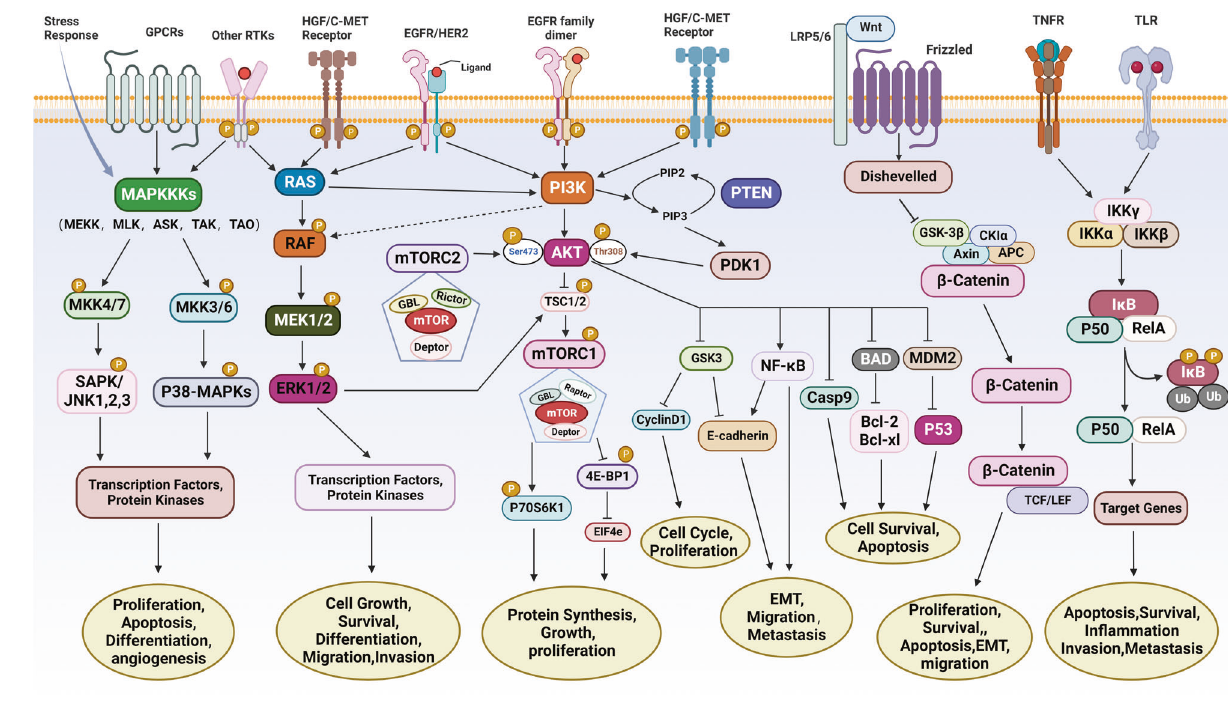
Fig. 2 Main signaling pathways and fundamental factors in gastric cancer. The major signaling and crosstalk of MAPK, HER2, PI3K/AKT/mTOR, HGF/c-Met, p53, Wnt/ β -catenin, and NF- κ B pathways, as well as their regulatory roles in cellular processes, are illustrated. GPCRs G-protein- coupled receptors, HGF hepatocyte growth factor, c-MET c-mesenchymal-epithelial transition factor, EGFR epidermal growth factor receptor, HER2/3/4 human epidermal growth factor receptor 2/3/4, MAPKKKs mitogen-activated protein kinase kinase kinases, RTKs receptor tyrosine kinases, RAS rat sarcoma, RAF rapidly accelerated fi brosarcoma, MKK mitogen-activated protein kinase kinase, SAPK/JNK jun amino-terminal kinase, p38-MAPKs p38 group of mitogen-activated protein kinases, MEK mitogen-activated protein kinase kinase, ERK1/2 extracellular signal- related kinase 1/2, PI3K phosphoinositide 3-kinase, AKT protein kinase B, mTORC1/2 mammalian target of rapamycin complex 1/2, PTEN phosphatase and tensin homolog, PDK1 phosphoinositide-dependent protein kinase 1, TSC1/2 tuberous sclerosis complex 1/2, p70S6K1 phosphorylation of ribosomal p70S6 kinase 1, 4E-BP1 eukaryotic translation initiation factor 4E (eIF4E)-binding protein 1, NF- κ B nuclear factor kappa-B, GSK3 glycogen synthase kinase 3, BAD Bcl-xl/Bcl-2-asociated death promoter, Casp9 cysteinyl aspartate speci fi c proteinase 9, MDM2 murine double minute 2, p53 tumor protein 53, EMT epithelial-mesenchymal transition, LRP5/6 low-density lipoprotein receptor-related protein 5/6, CKI α casein kinase I α , APC adenomatous polyposis coli, TCF/LEF T-cell factor/lymphoid enhancer factor, TNFR tumor necrosis factor receptor, TLR toll-like receptors, IKK I κ B kinase. This fi gure was created with